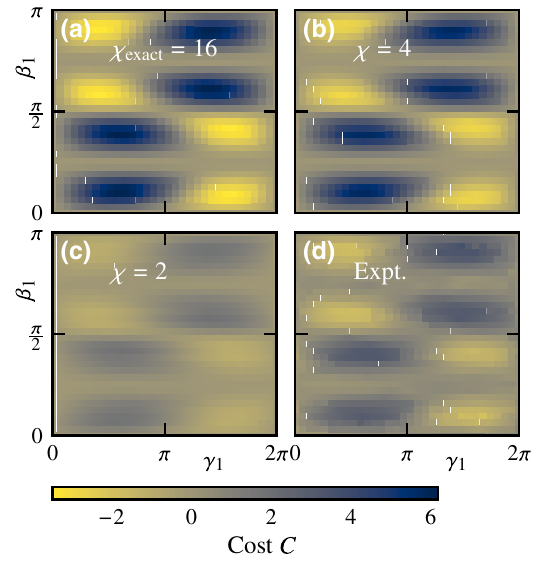
FIG. 4. The cost landscape for the N = 8 unit-weight 3- regular graph of Fig. 5(b) versus the two parameters γ 1 and β 1 of a one-layer QAOA circuit. (a)–(c) Matrix-product-state sim- ulations with χ ≡ χ exact = 16, χ = 4, and χ = 2, respectively.